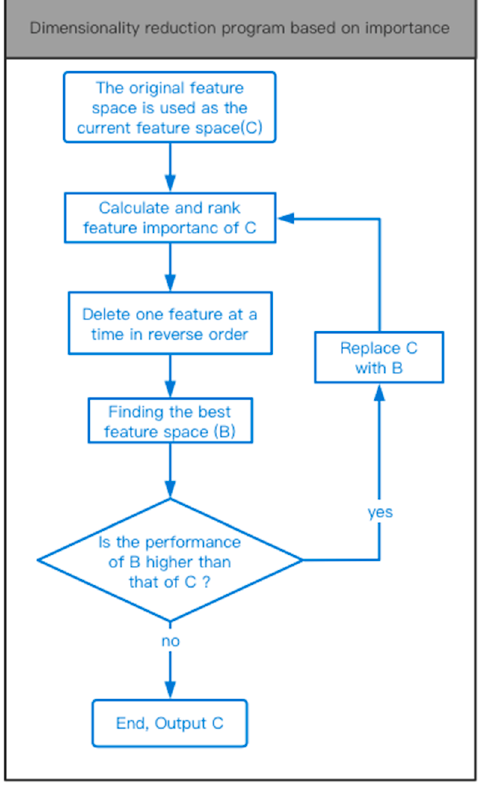
Figure 5. The process of dimensionality